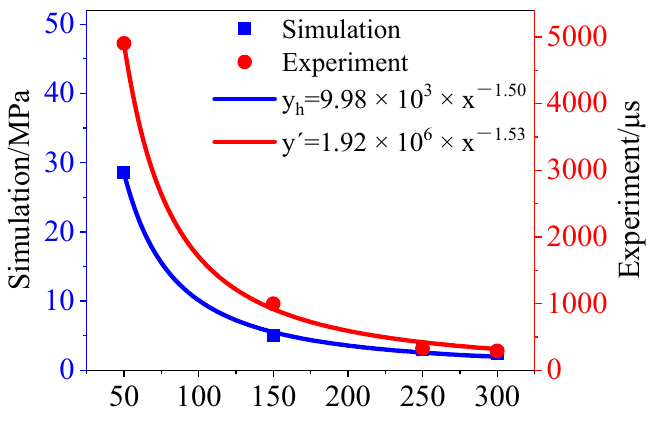
Figure 17. Coal crack propagation obtained from numerical simulation.